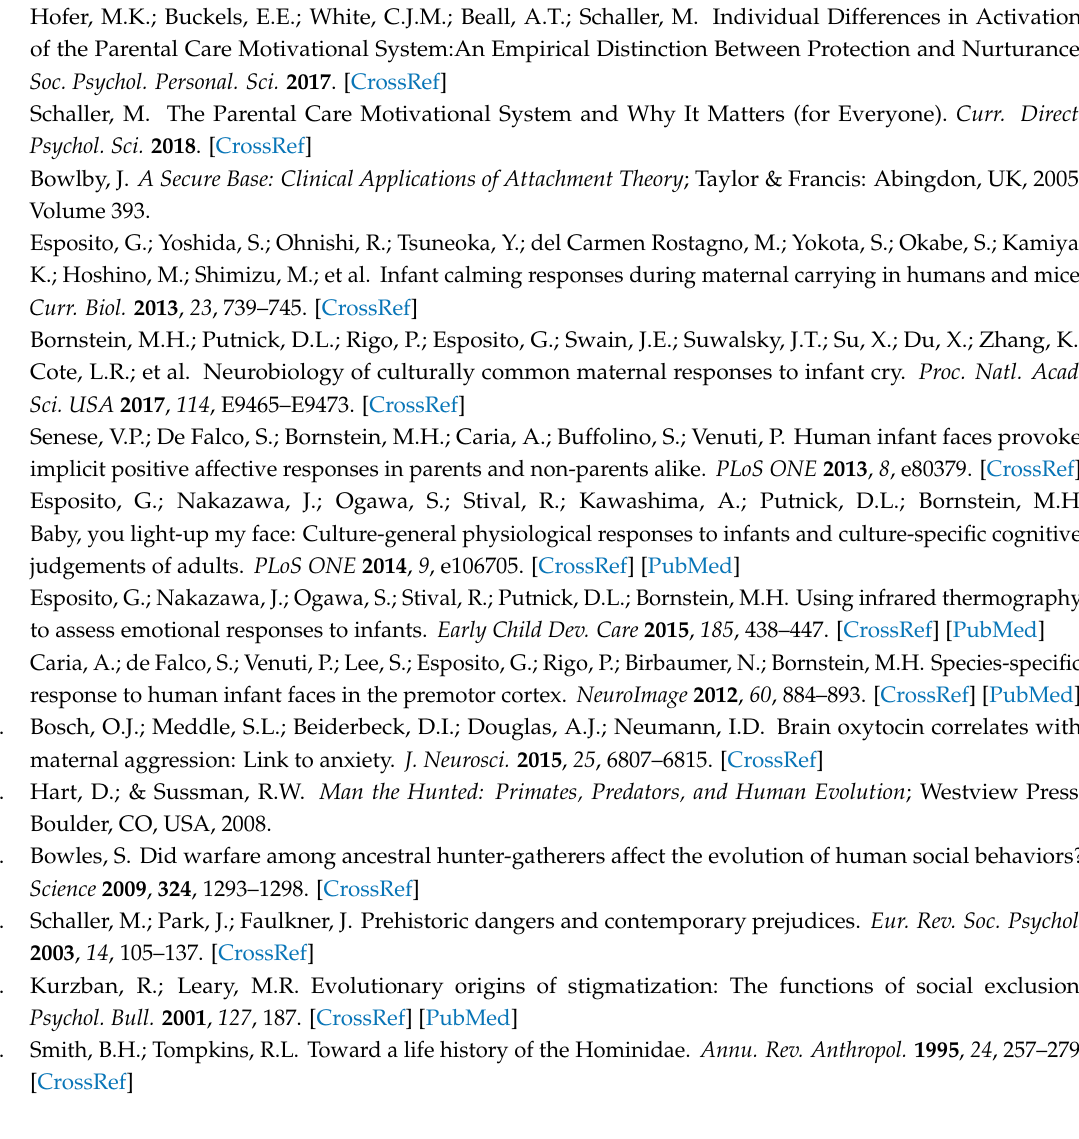
Table S1: Means and standard deviations (in parentheses) across the four face stimuli conditions (females, males, infants, and puppies) in Study 1, Table S2: Means and standard deviations (in parentheses) across the four face stimuli conditions (Whites, Arabs, Asians, and puppies) in Study